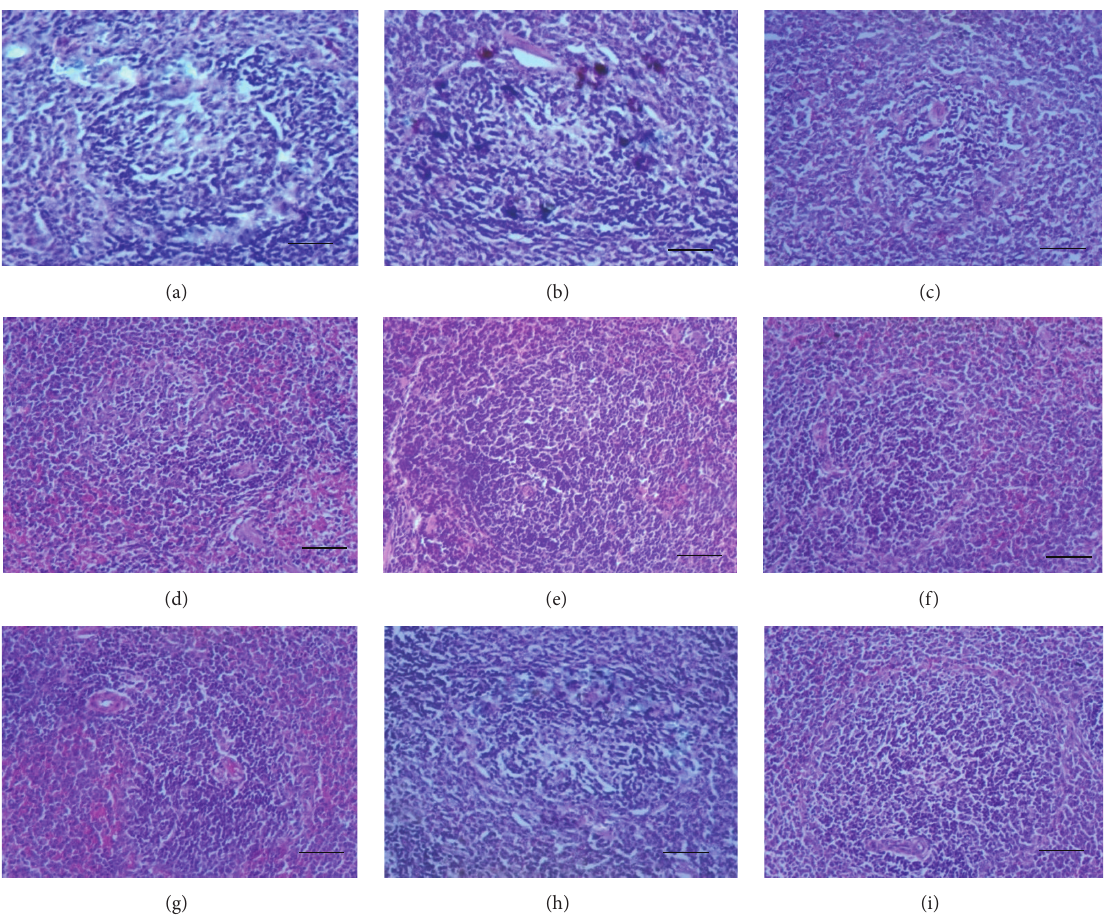
Figure 3: Photomicrograph of spleen sections. (a) Normal control: normal architecture of spleen with presence of marginal zone between red and white pulp. (b) Negative control: hypercellularity and haemosiderosis with loss of marginal zone and dilatation of blood vessels. (c) Positive control: it shows no sign of hypercellularity or haemosiderosis. Sections (d) (10mg/kg YL), (e) (10mg/kg OL), (f) (30 mg/kg YL), (g) (30 mg/kg OL), (h) (300 mg/kg YL), and (i) (300 mg/kg OL) all show evidence of hypercellularity of resident cells and absence of haemosiderosis (H&E stain 100x). Bar = 20 𝜇